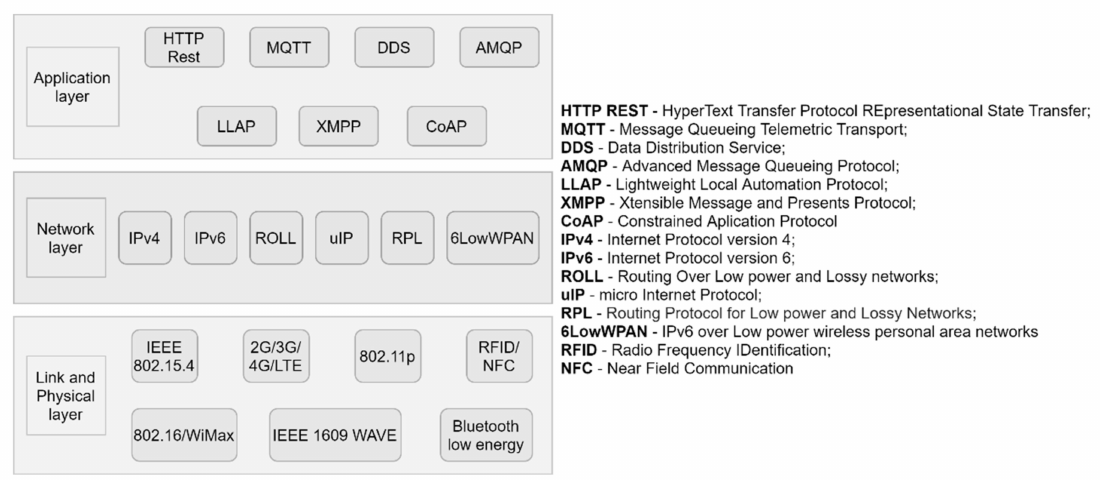
Figure 5. Protocols on the Internet of